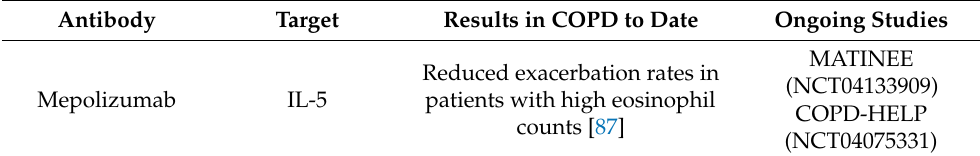
Table 2. A summary of ongoing trials of assessing mABs approved for asthma in the treatment of